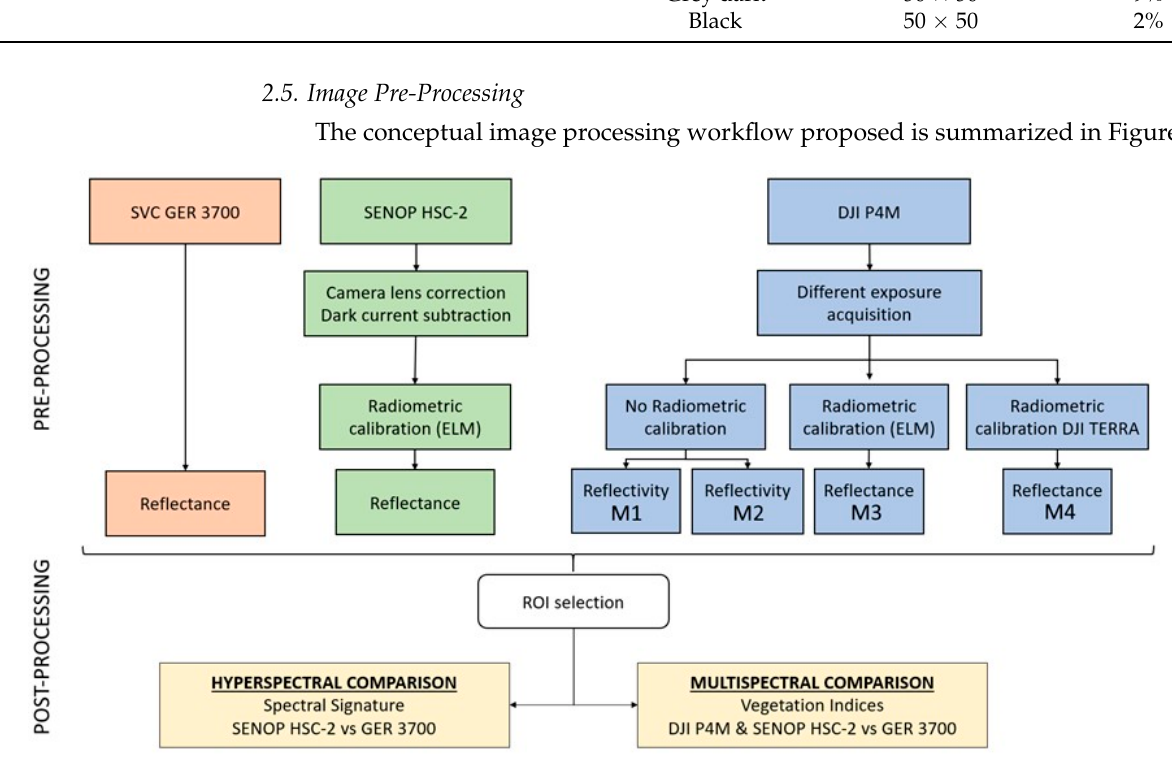
Figure 4. Image processing